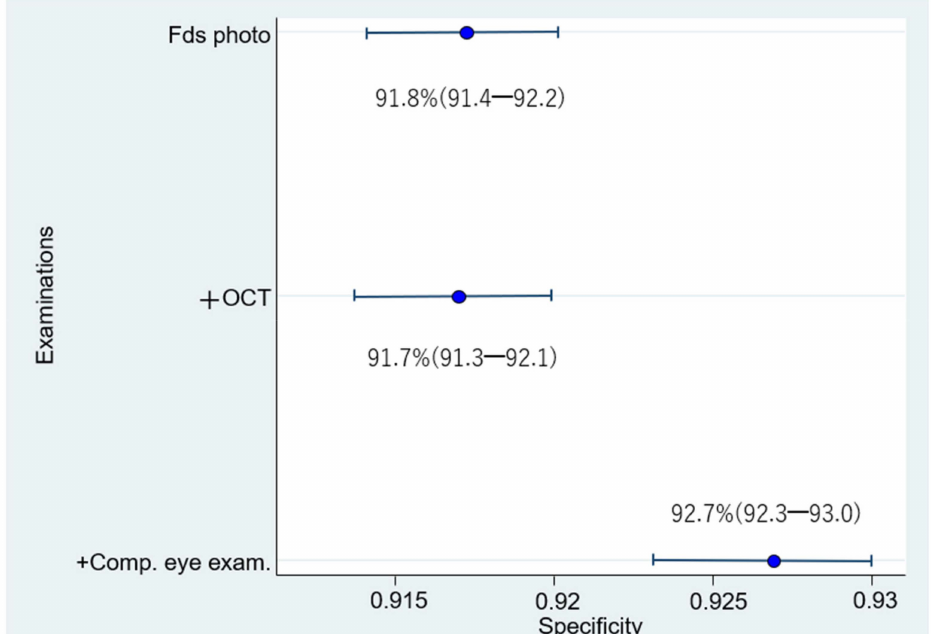
Figure 6. Specificity for diagnosis by 24 doctors. The specificity for diagnosis by 24 doctors is significantly higher for fundus photography + OCT + comprehensive examination than for fundus photography alone or fundus photography +